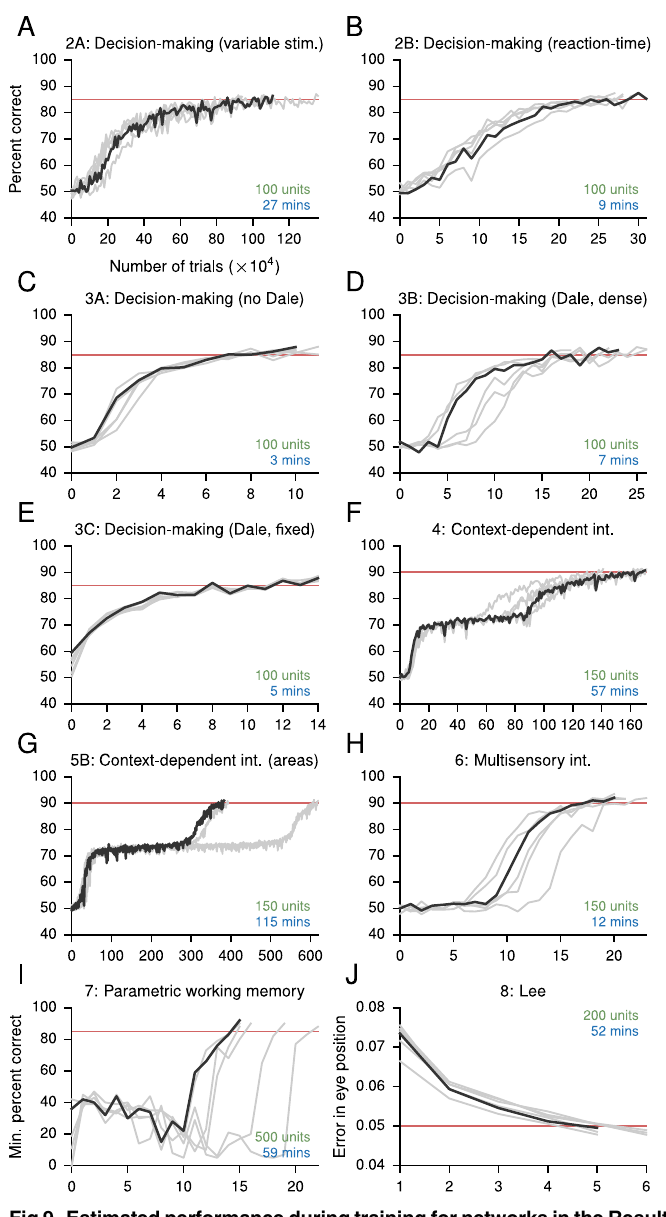
Fig 9. Estimated performance during training for networks in the Results. (A)-(I) Percentage of correct responses. (J) Error in eye position. For each network the relevant figure in the main text and a brief description are given. Black lines are for the networks shown in the main text, while gray lines show the performance for 5 additional networks trained for the same tasks but using different initial weights. Red lines indicate the target performance; training terminated when the mean performance on several (usually 5) evaluations of the validation dataset exceeded the target performance. In I the target performance indicates the minimum, rather than mean, percentage of correct responses across conditions. The number of recurrent units (green) is indicated for each network. The number of minutes (in “ real-time ” ) needed for training (blue) are estimates for a MacBook Pro running OS X Yosemite 10.10.4, with a 2.8 GHz Intel Core i7 CPU and 16 GB 1600 MHz DDR3 memory. GPUs were not used in the training of these